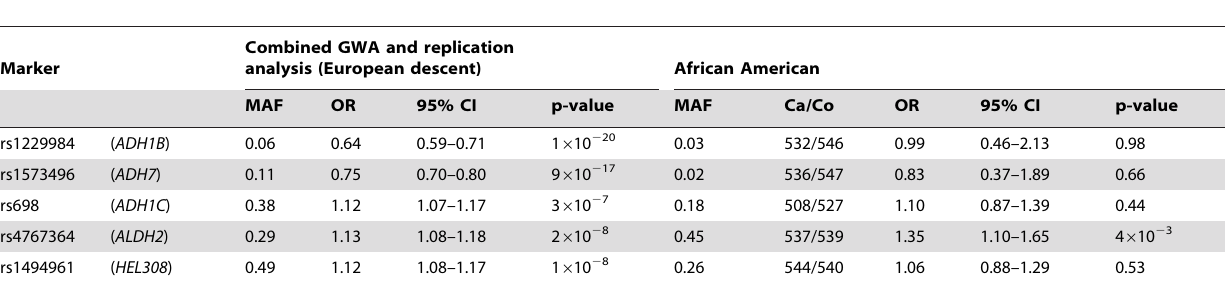
Table 3. Comparison of results from the genome-wide analysis with analysis in a UADT case-control series of African-American